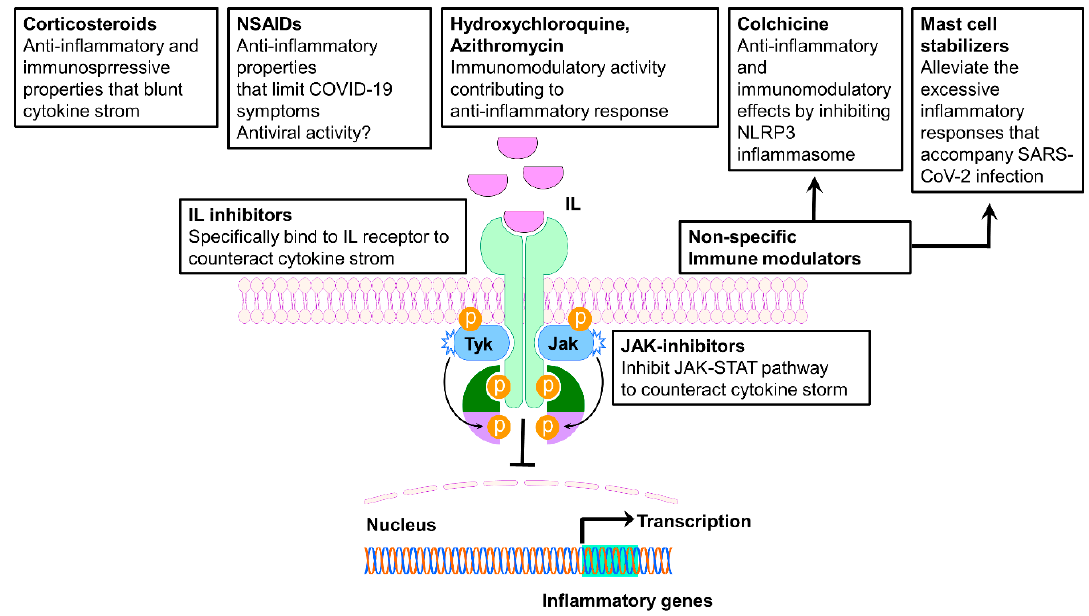
Figure 3. Schematic representation of the immunomodulatory and anti-inflammatory drugs’ site of action. IL, interleukin; IL-R, interleukin receptor; JAK, Janus kinase; JAK-STAT, Janus kinase-signal transducer and activator of transcription.